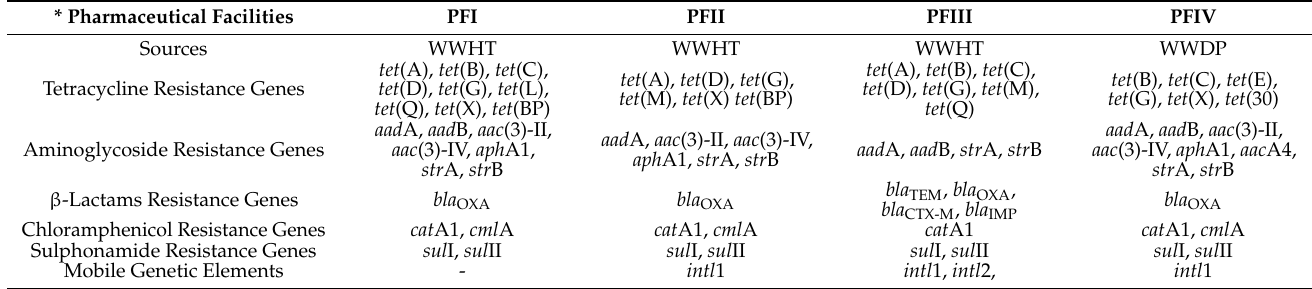
Table 2. Antibiotic resistance genes and mobile genetic elements from metagenomic genes obtained from pharmaceutical facilities’